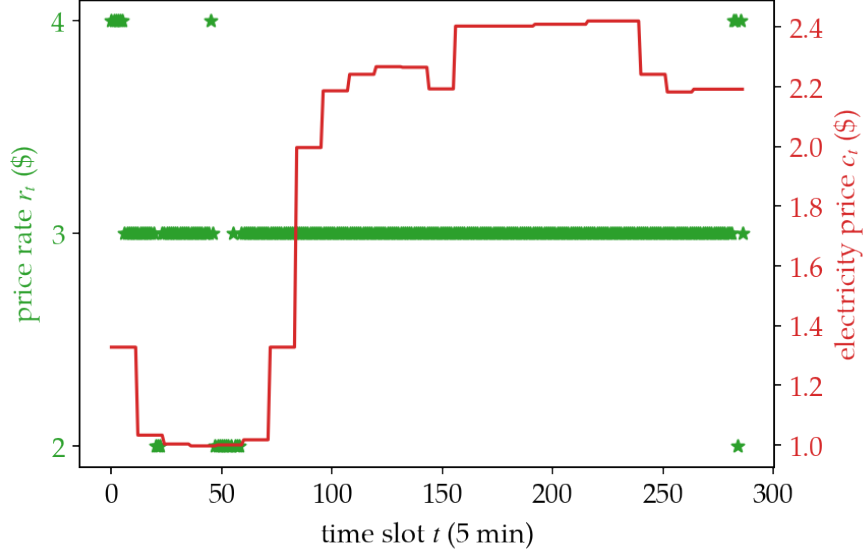
Figure 11. Price announced to customers vs. electricity price paid to the utility company.